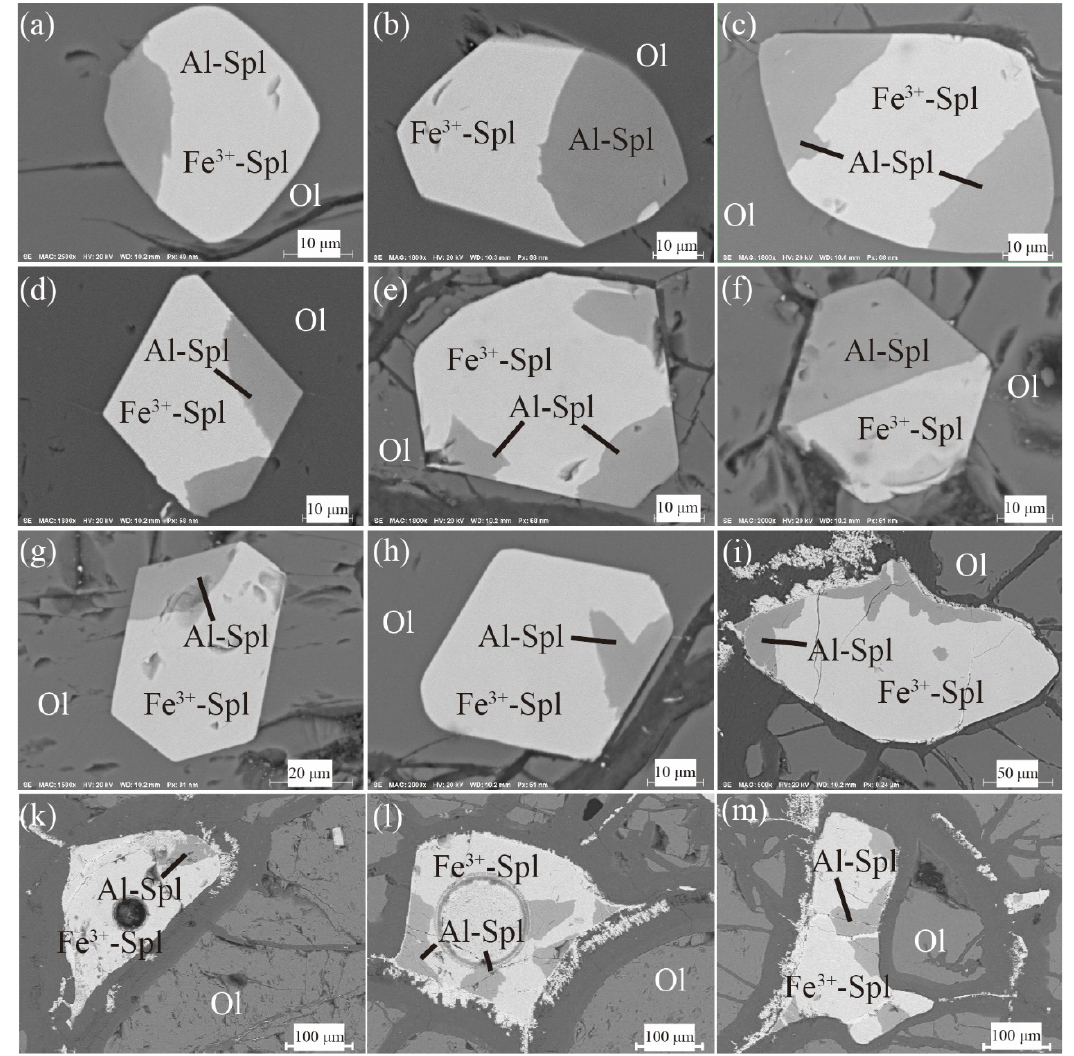
Figure 5. BSE images of euhedral type B spinel ( a – h ) in olivine and interstitial anhedral type B spinel ( i – m ).